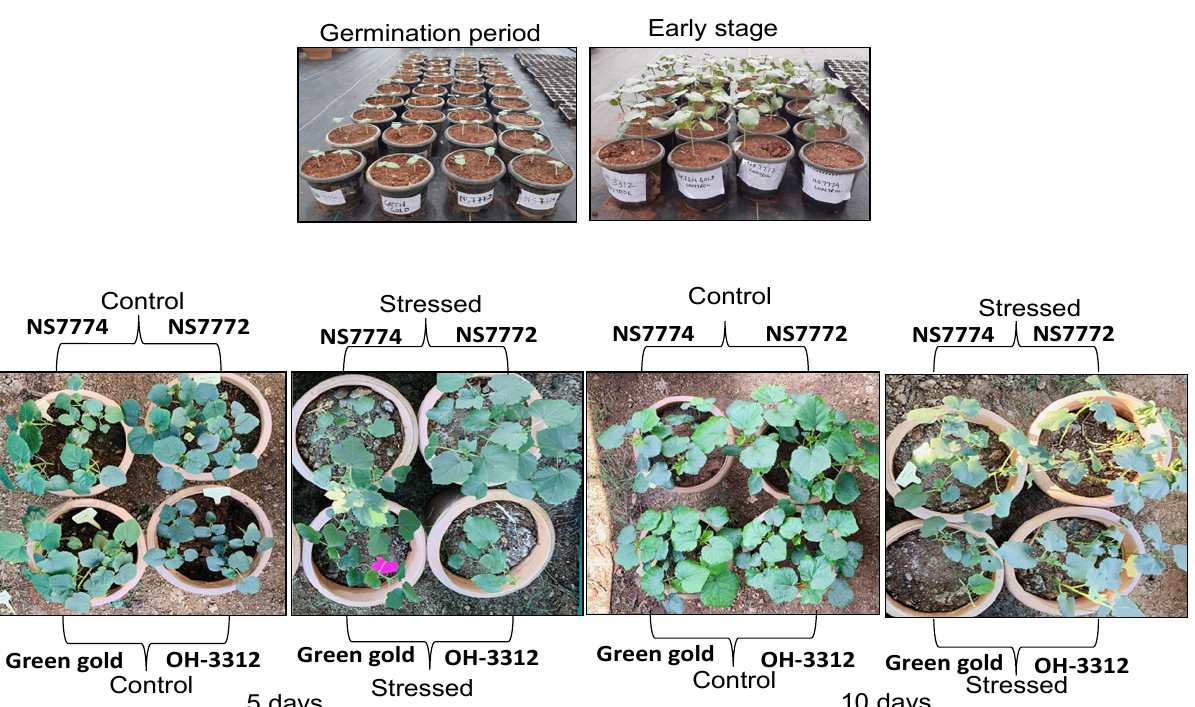
Figure 1. Morphological representation of okra genotypes NS7774, NS7772, Green Gold, and OH3312. Photographs represent the early germination period, early stage and vegetative stage induced by drought stress along with control plants. A total of 5 days represent an early stage, and 10 days represent the late stages of the drought period.